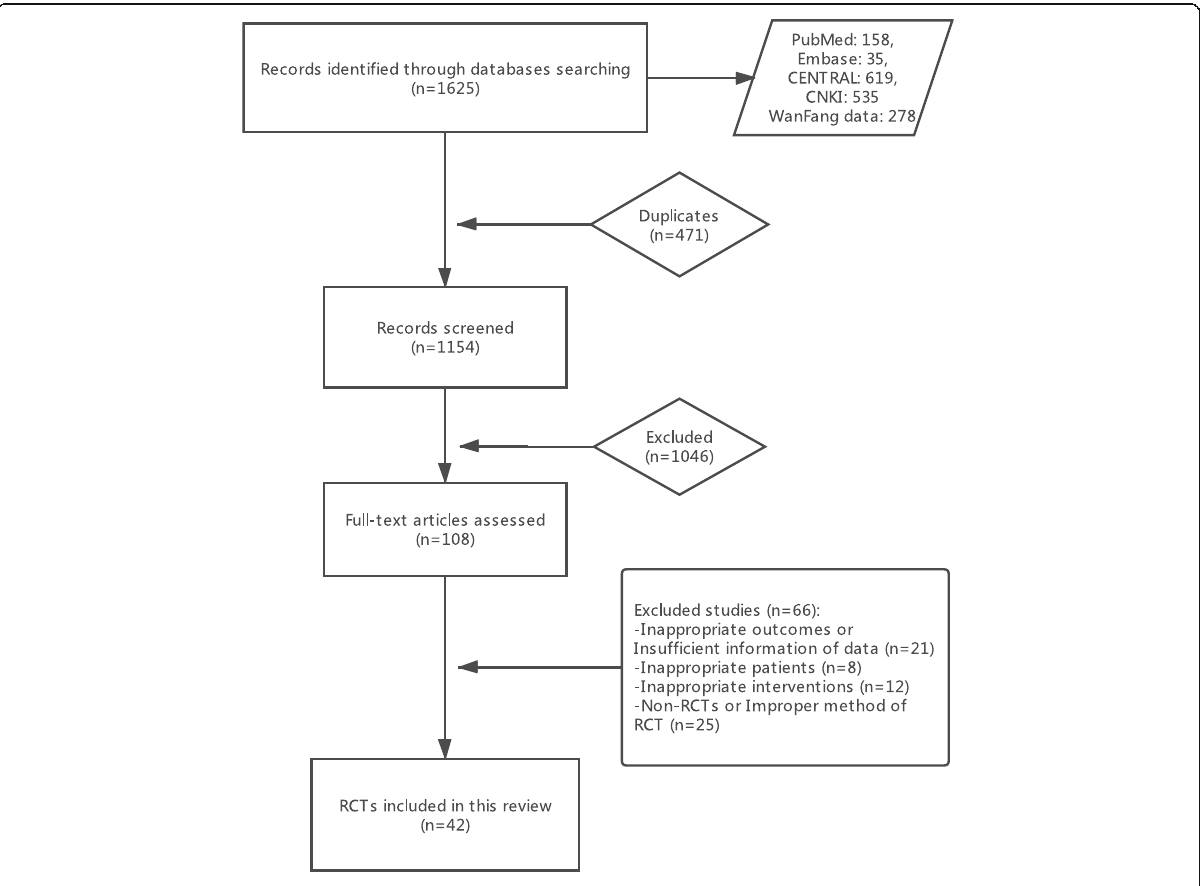
Fig. 1 Flowchart of study selection and